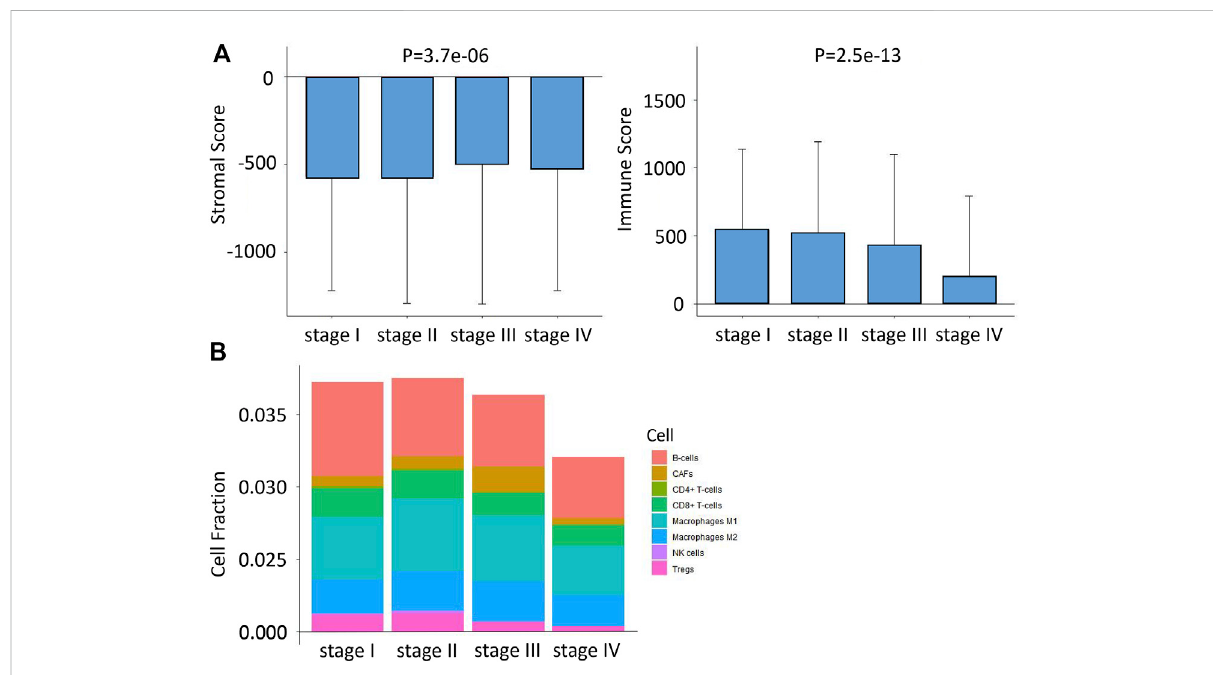
FIGURE 2 Differences in immune in fi ltration characteristics among the four stages. (A) Differences in stromal score and immune score among the four stages based on xCell algorithms. (B) Differences in eight immune cell scores among the four stages based on ESTIMATE algorithms.